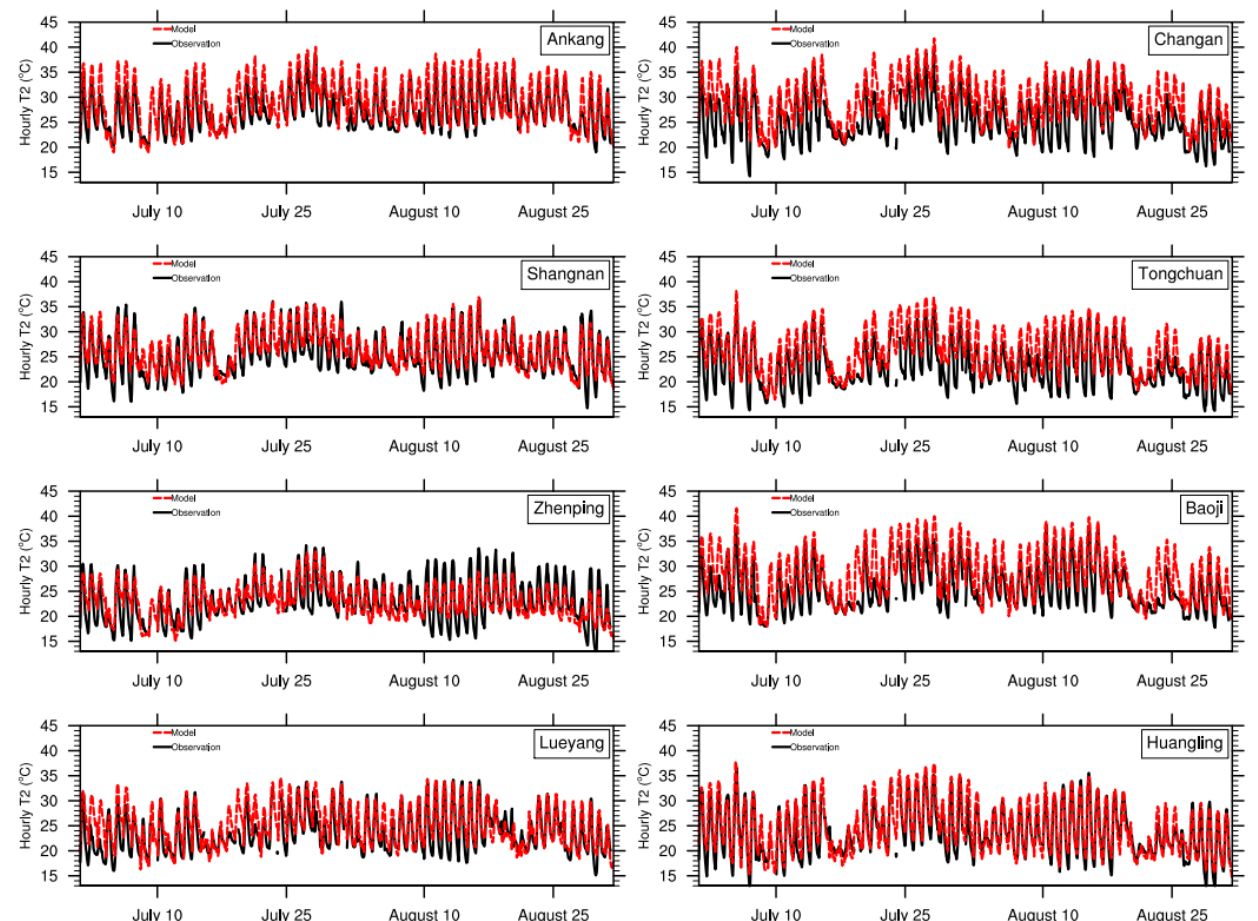
Figure 3. Comparison of evolution of hourly air temperature at 2 m (T2) between CTRL simulation (red dashed lines) and the dataset from 8 meteorological stations of Ankang, Changan, Shangnan, Tongchuan, Zhenping, Baoji, Lueyang, and Huangling (black solid lines), whose location is showed in Figure 2.